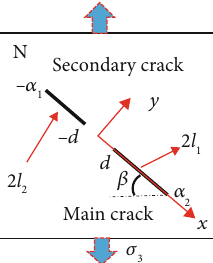
Figure 5: Mechanical model of unequal collinear cracks under uniaxial